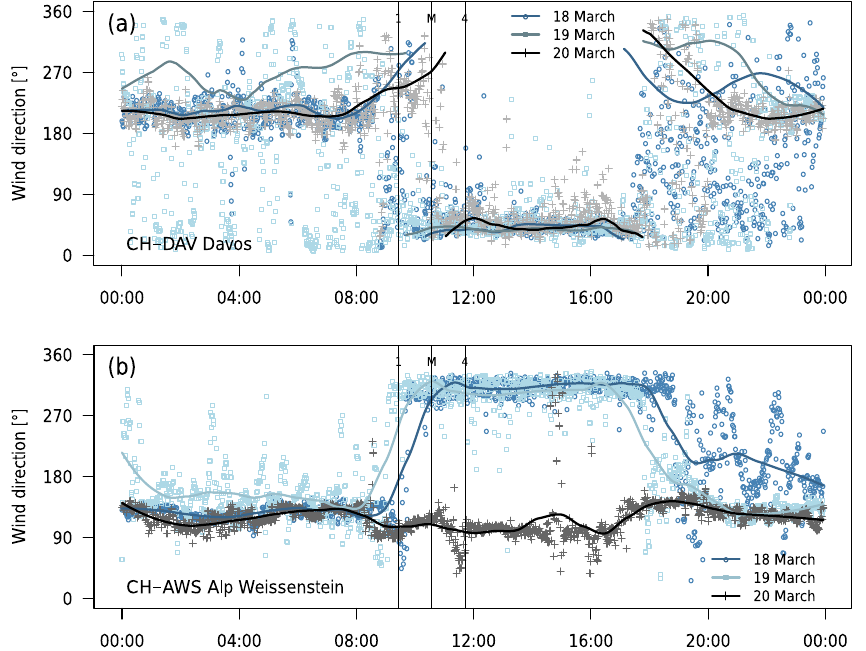
Figure 7. Wind direction as a function of time at (a) CH-DAV and (b) CH-AWS on 18, 19, and 20 March, showing a delayed wind direction reversal at CH-DAV on 20 March (a) , and a suppression of the typical wind reversal at CH-AWS on 20 March (b) determined from 1min average data. The bold lines are local polynomial regression (loess) fits.